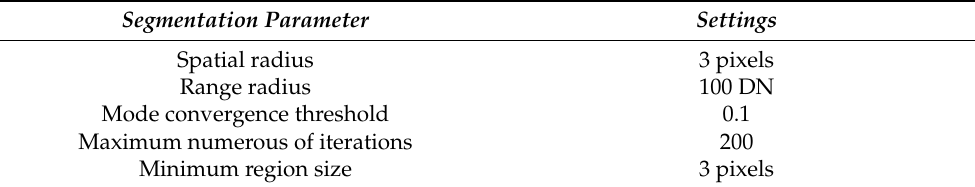
Table 6. Segmentation settings in SAGA